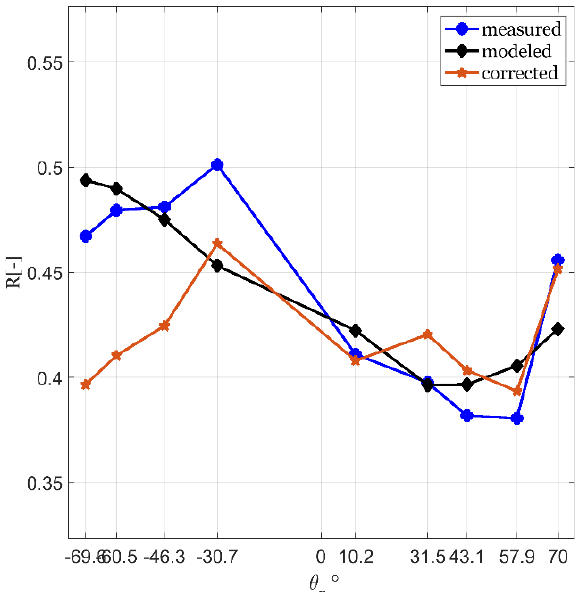
Figure 6 . The measured, modeled, and corrected reflectance values at different zenith angles for profile 90-270 degrees at wavelength 513.4 nm.